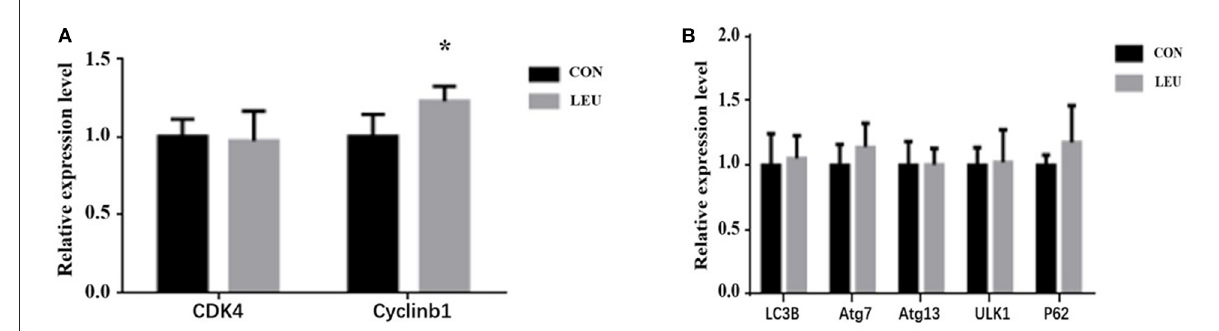
FIGURE4 Effects of dietary leucine supplementation on gene expression related to cell proliferation (A) and autophagy (B) in the testis of boars. CON, control group; LEU, leucine group. Values are means, with their standard errors represented by vertical bars ( n = 15), * means P < 0.05. CDK4, Cell Cycle Dependent Kinase 4; cyclinb1, cell cycle protein; LC3B, microtubule-associated protein 1 light chain 3b; Atg, autophagy-related gene; ULK1, Unc-like kinase 1; P62, autophagy-related protein 62.